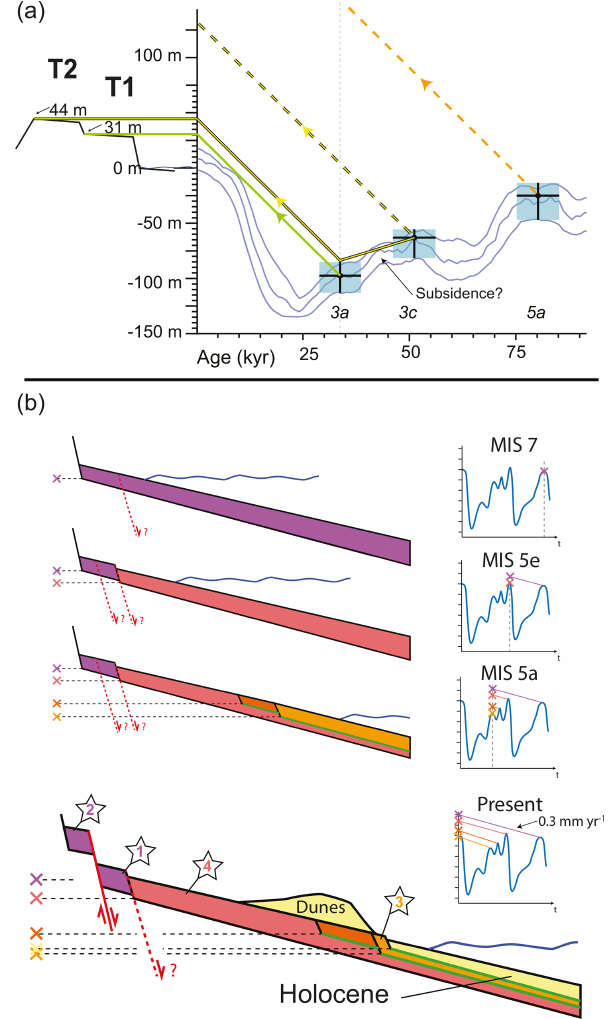
Figure 11. Geological implications and issues associated with the dating results. (a) Uplift rate history of Pasabander T1 and T2 at Beris village (profile A–B in Fig. 7a) (see text). Sea-level curve from Spratt and Lisiecki (2016). (b) Sketch of a possible terrace carving/reoccupation and sediment deposition scenario for the main Chabahar–Ramin T1 (profile C–D, Fig. 6d), with an uplift rate of ∼ 0 . 3mmyr − 1 . Inset: sea-level history. Throughout the successive highstands, the sea reoccupies only the lower portion of the terrace as the land uplifts. The position of the samples and sedimentary logs presented in Fig. 6e is added. Flooding surfaces within the sedimen- tary deposits are represented as green lines. Vertical scale exagger-